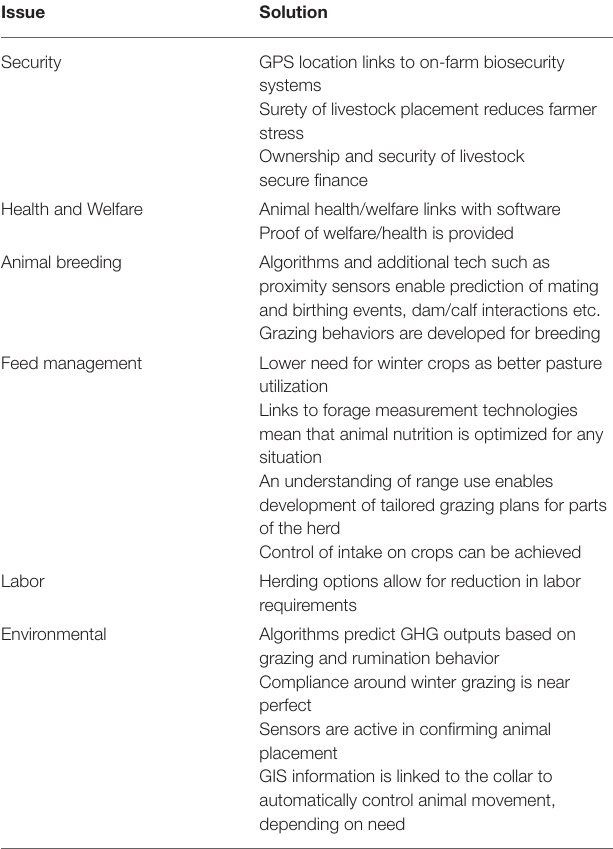
TABLE 1 | A range of issues and solutions that digital sensors may provide when linked to the collar containing virtual herding technology, identified at a lead-user workshop in 2019, Hamilton, New